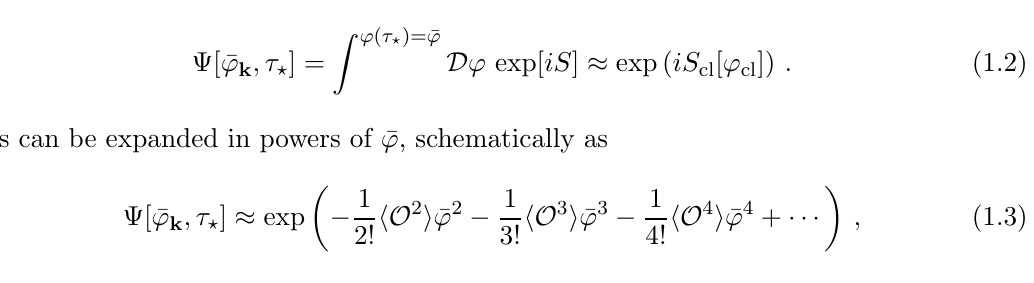
− 1 , while three- and four-point vertices correspond T 2 h i T 3 and Re T 4 , respectively. Note that these diagrams have a fundamentally h i h i